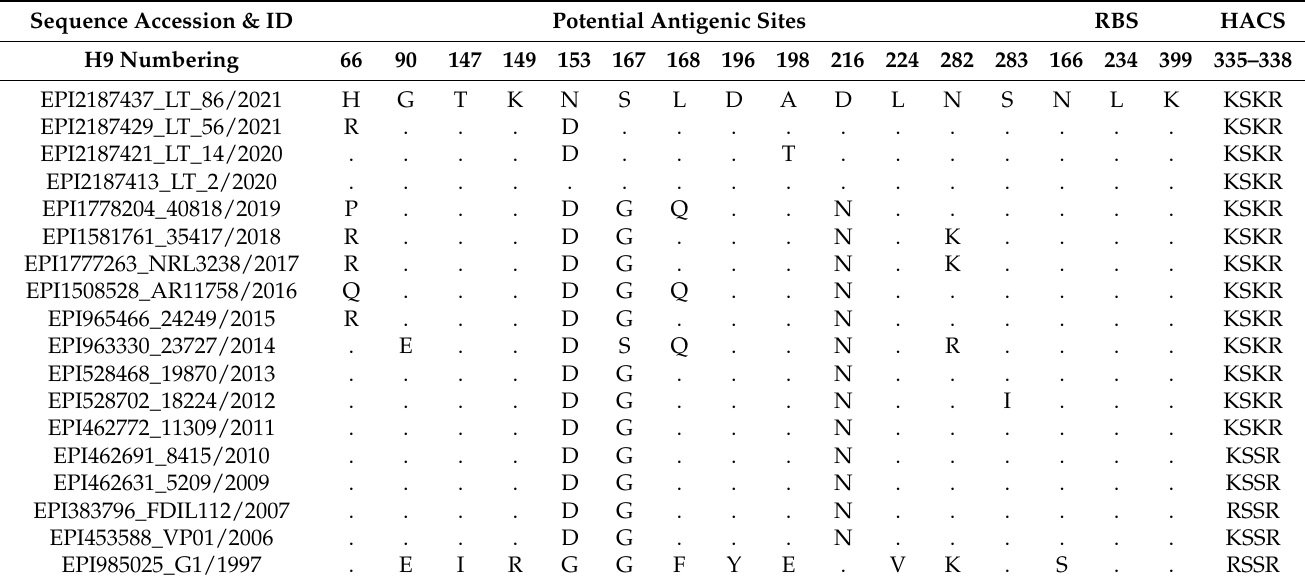
Table 1. Differences in amino acid sequences in the HA protein of four Bangladeshi isolates, as well as other selected Bangladeshi strains and the G1 reference